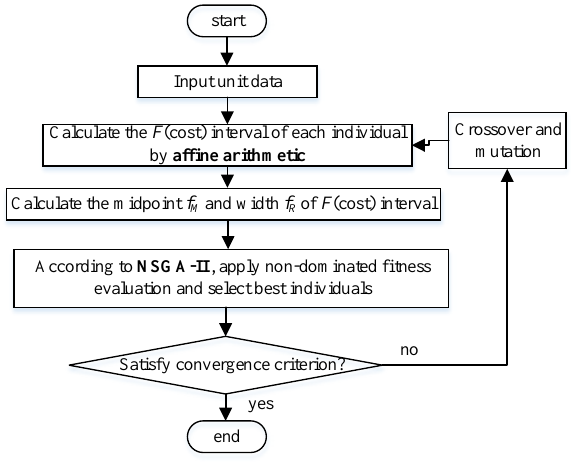
Figure 2. Flowchart for solving the unit commitment model.